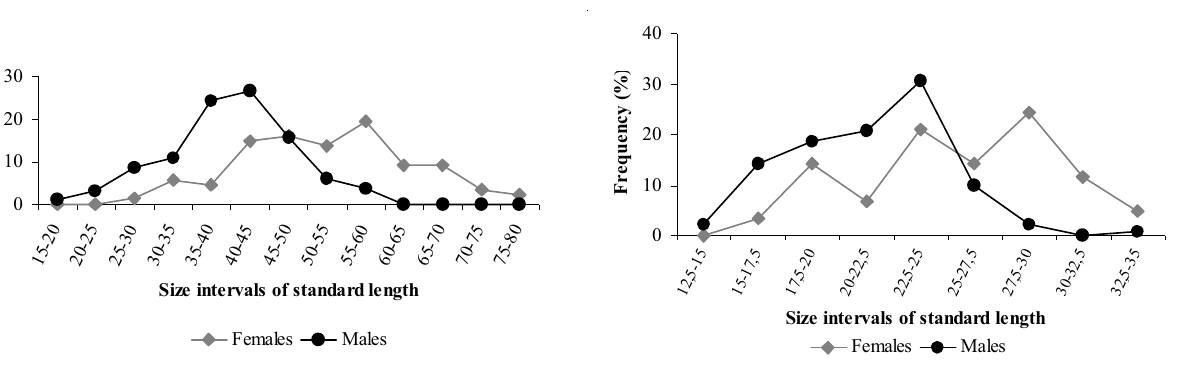
Fig. 7. Sexual proportion of males and females of Astyanax paranae for each size intervals of the standard length.